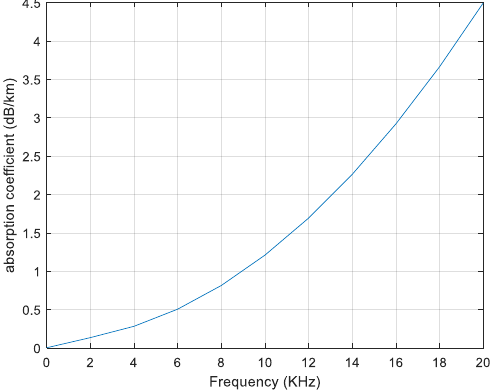
ffi cient 10log a ( f )